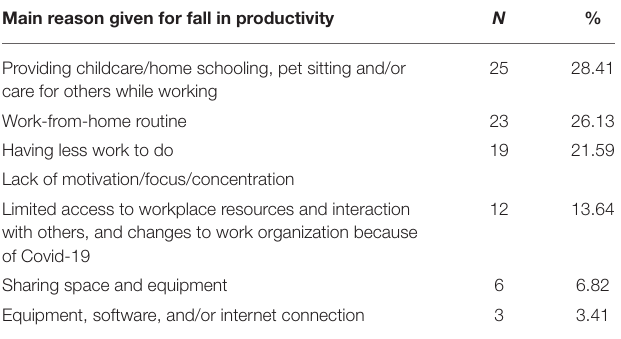
TABLE 4 | Main reason given for fall in productivity ( N = 88).